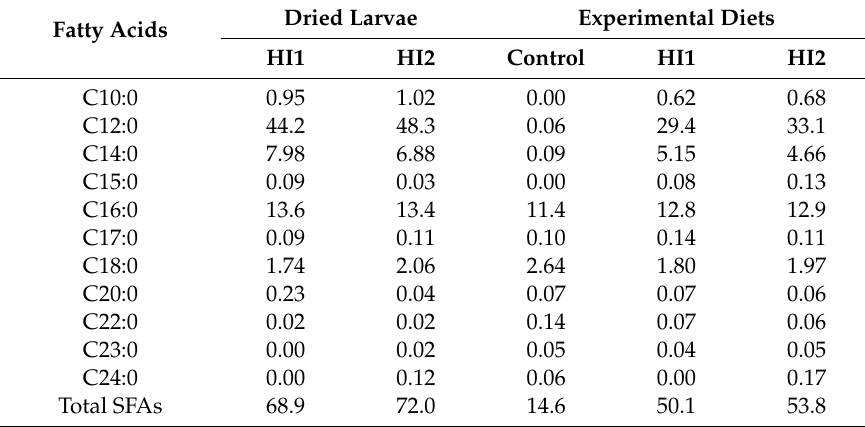
Table 1. Fatty acid profile (% of total FAMEs) of the dried Hermetia illucens (HI) larvae reared on layer mash (HI1) or on 50:50 layer mash and fish o ff al (HI2) and of the experimental diets: Control and Control diet including either 10% HI1 or